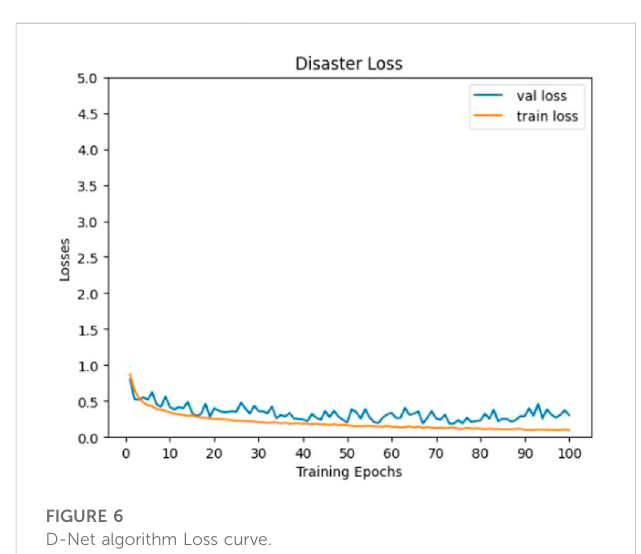
FIGURE 6 D-Net algorithm Loss